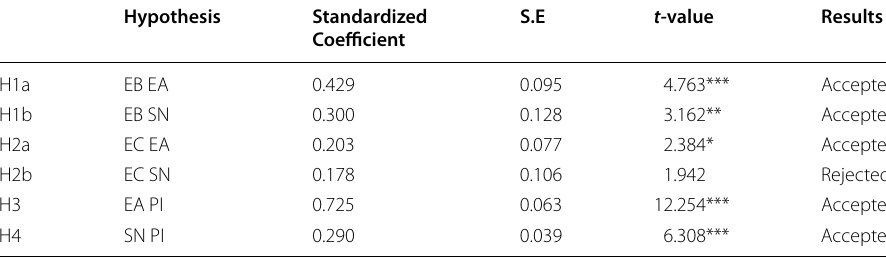
Table 4 Result of structural equation modeling and model